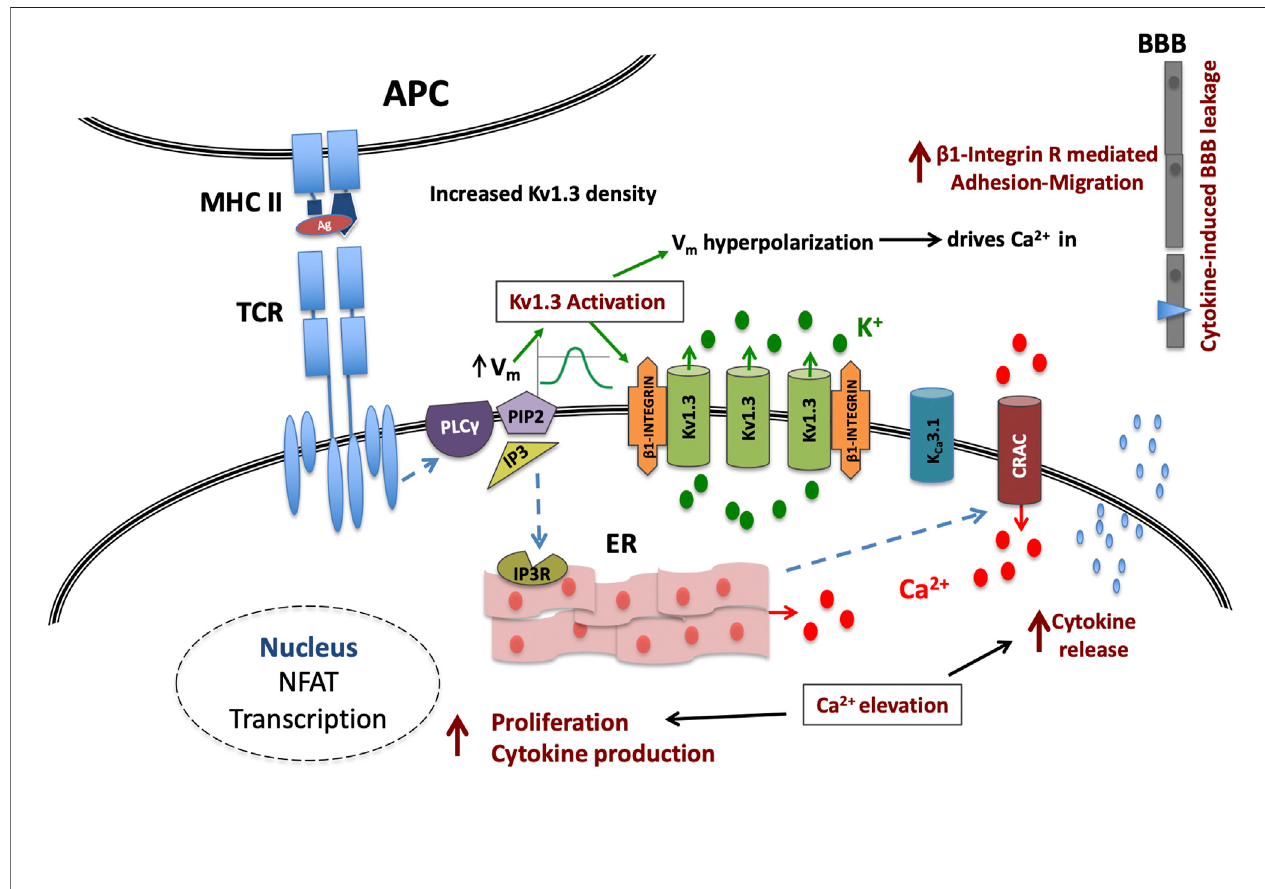
FIGURE 5 | Kv1.3 channel up-regulation enhances signaling in MS T cells. Upon TCR antigenic (Ag) stimulation, the IP3-induced calcium release from the intracellular stores (ER) causes on one hand membrane depolarization (Vm), followed by a Kv1.3 channel-mediated hyperpolarization and on the other, the formation of conductiveCalciumReleaseActivatedCalcium(CRAC)channels;inMS-TcellsthishyperpolarizationwillbeofincreasedmagnitudeduetohigherKv1.3channeldensity. This in turn will translate into a stronger than physiological driving force for calcium ions (Ca 2+ ) through CRAC channels and therefore a cytosolic calcium signal of ampli fi ed intensity and duration that in turn will potentiate the effectiveness of the immune stimulus, and may even allow sub-threshold stimuli to reach activation threshold, priming T cell activation that otherwise would not. Additionally all calcium-dependent processes that follow the successful activation of MS T cells, such as cytokine production, cytokine secretion and proliferation, will be heightened. Moreover, the immune stimulus-induced Kv1.3 activity in these cells, will increase β 1- integrin activation, facilitating their adhesion and cytokine-induced migration into the